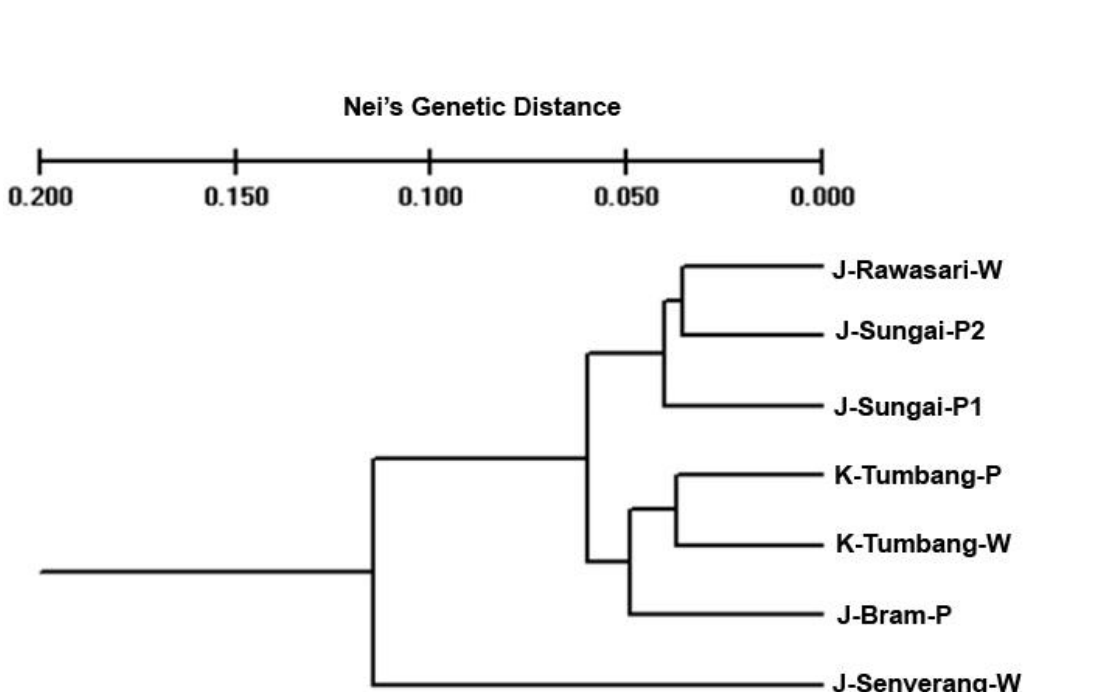
Figure 2. Phenogram based on Nei’s genetic distance generated from 280 AFLP markers for 100 Dyera polyphylla individuals sampled from seven populations. Validation within 1000 bootstraps. The population codes are explained in Table 1. Distances are expressed on a dimensionless 0–1 scale from zero to maximum dissimilarity in terms of the criteria